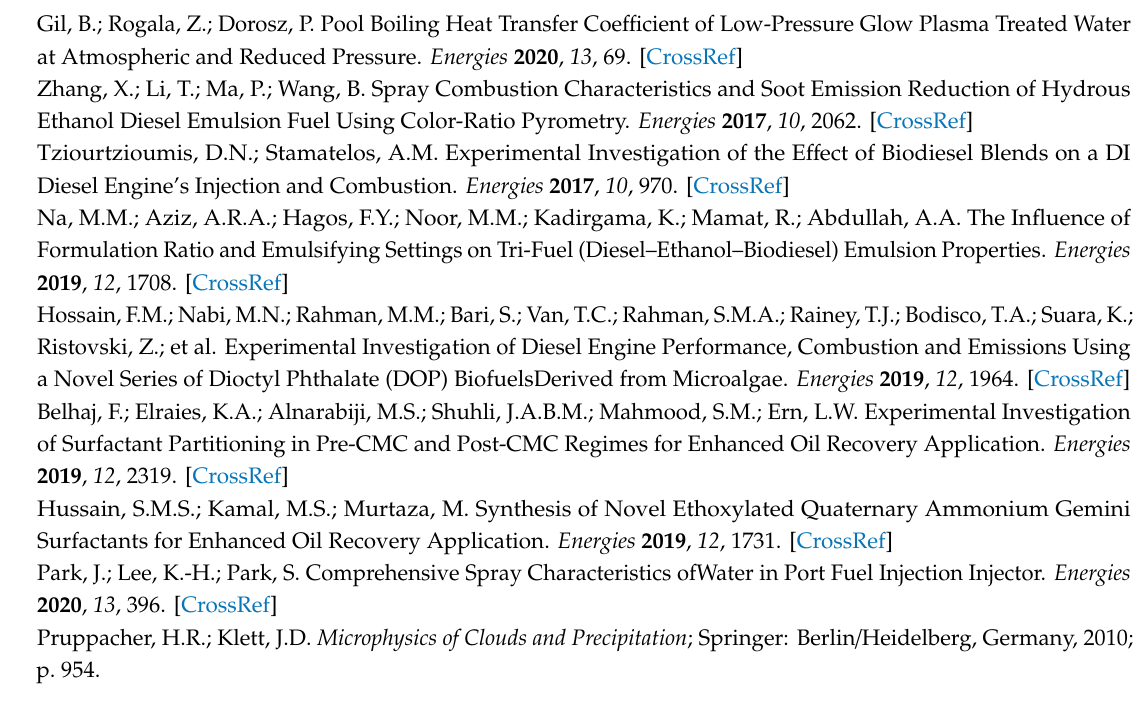
Figure S1: A still at 5 ◦ C, Figure S2: A still at 15 ◦ C, Spreadsheet “Surface tension determination for water-air